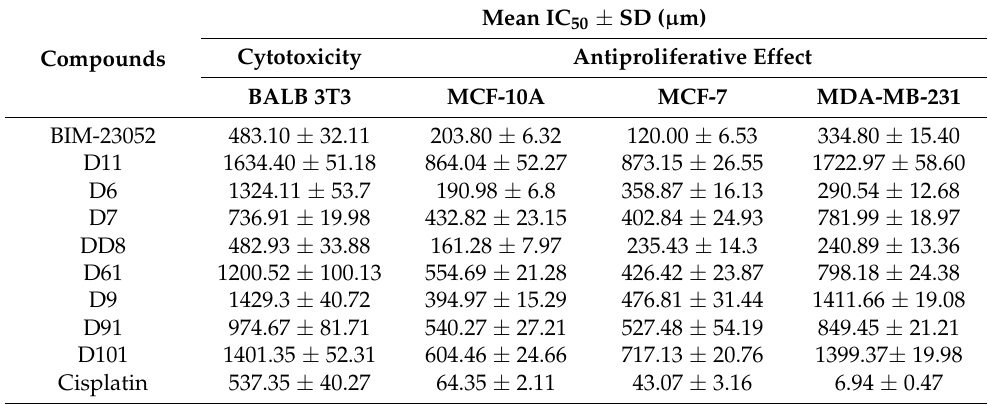
Table 3. Cytotoxic and antiproliferative effects of the studied BIM-23052 analogs.